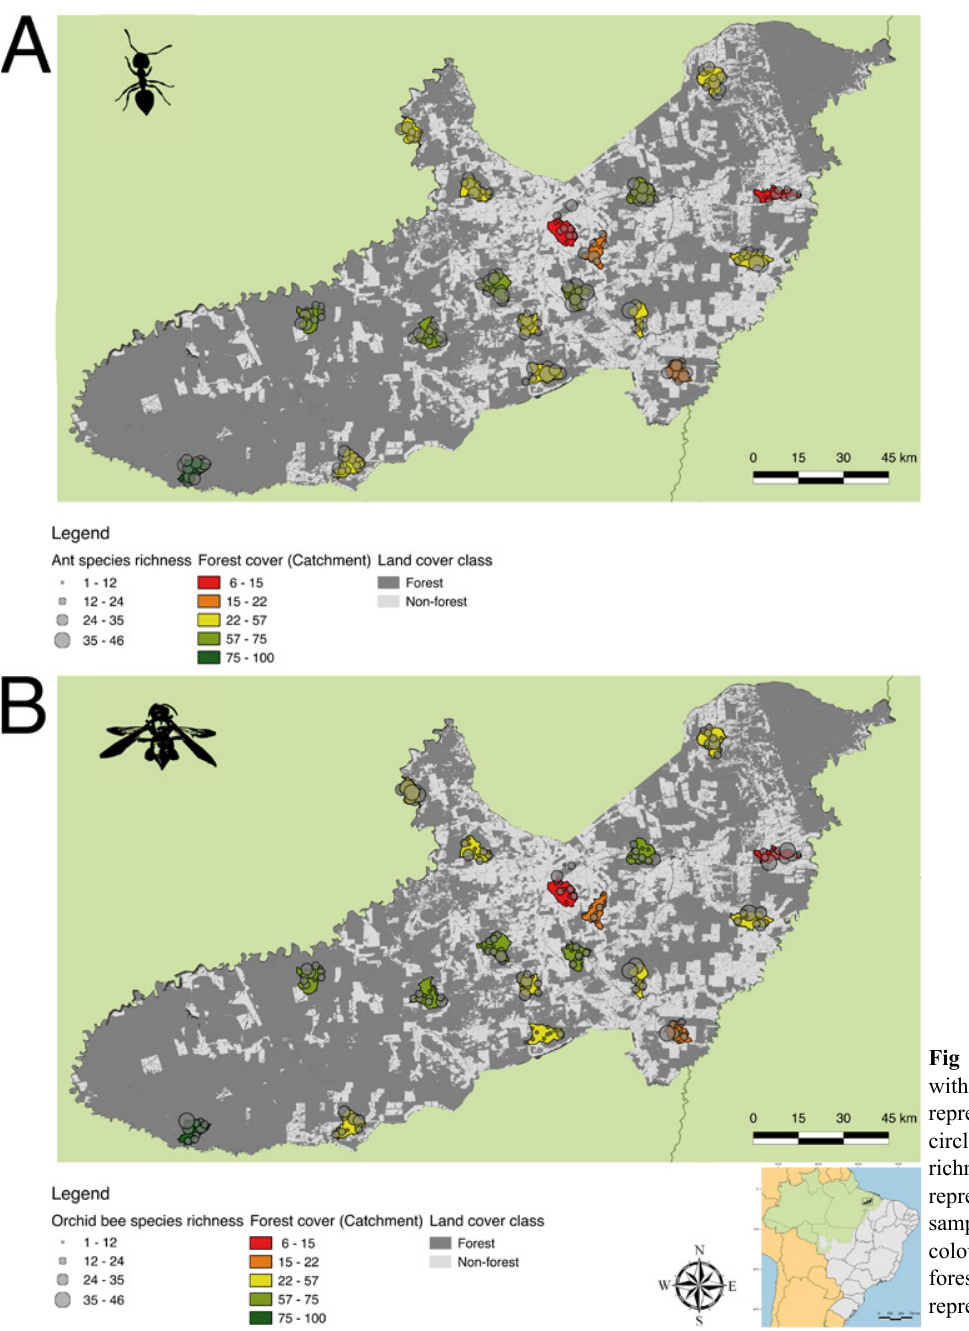
Fig 1 . Map of the sampling region within the Brazilian contexts. Circles represent each sampled transect and circle sizes represent relative species richness for each taxa. In colours are represented micro-catchments, where samplings were located and greener colours represent higher primary forest cover, while redder colours represent lower primary forest